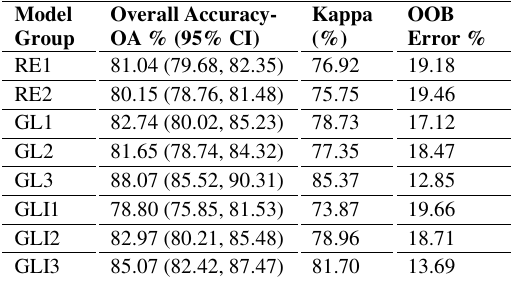
Table 4: Classification accuracies of different feature models based on the Random Forest (RF) classifier algorithm.